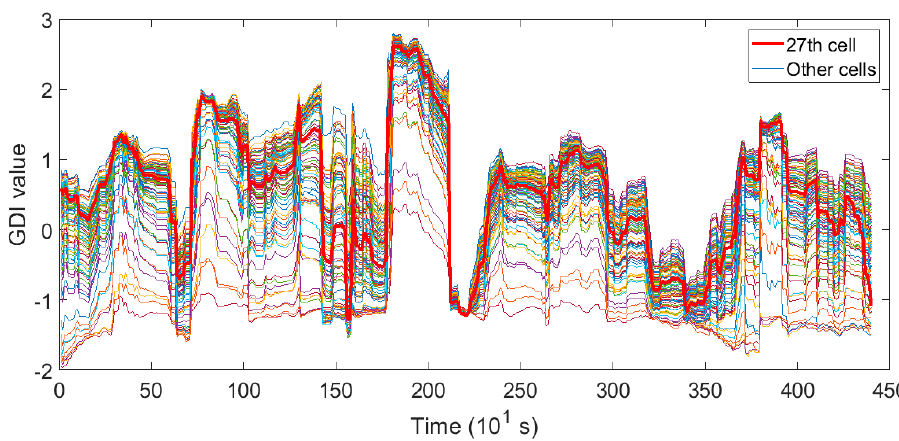
Figure 3. GDI waveforms in the first